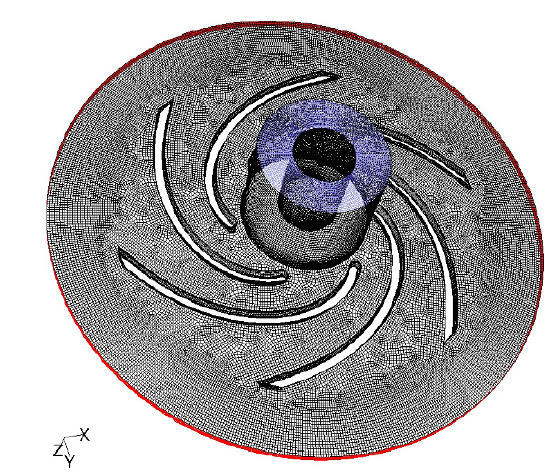
Figure 8. Development of cavitation for impeller E3 (Q=2m3/h) - NPSH = 3,3 m. Colours illustrates the fraction of gaseous phase.